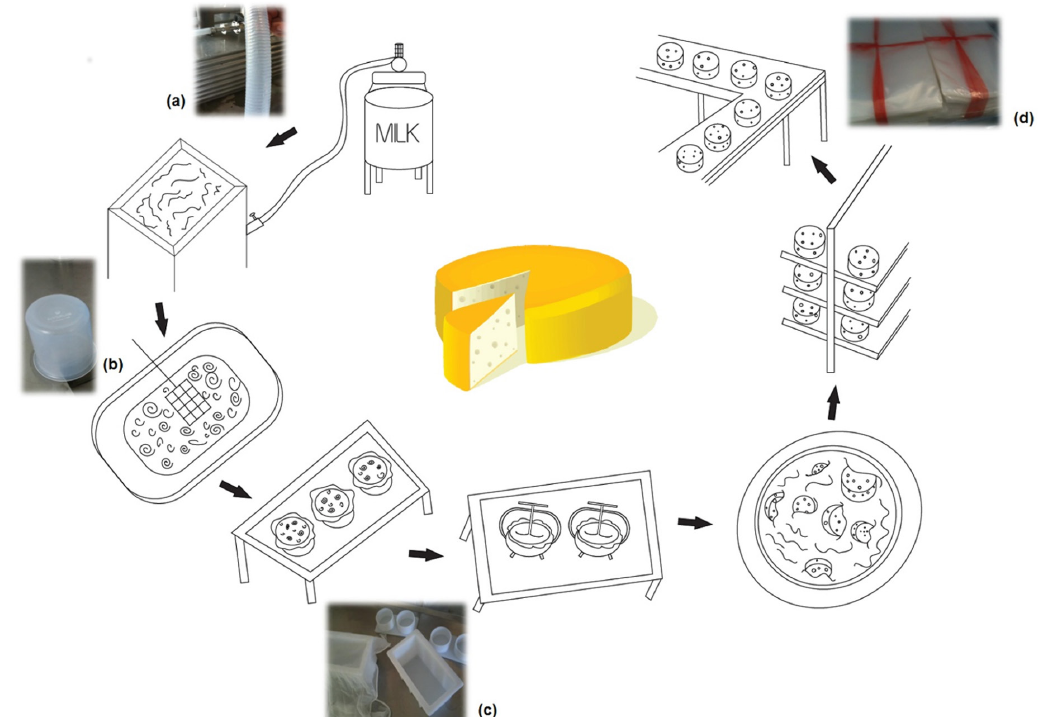
Figure 1. Illustration of the production process of colonial cheese and steps where utensils are employed: (a) hose used to transfer milk, (b) beaker used to transfer the curd, (c) mold used in cheese forming and (d) package employed in the vacuum packaging